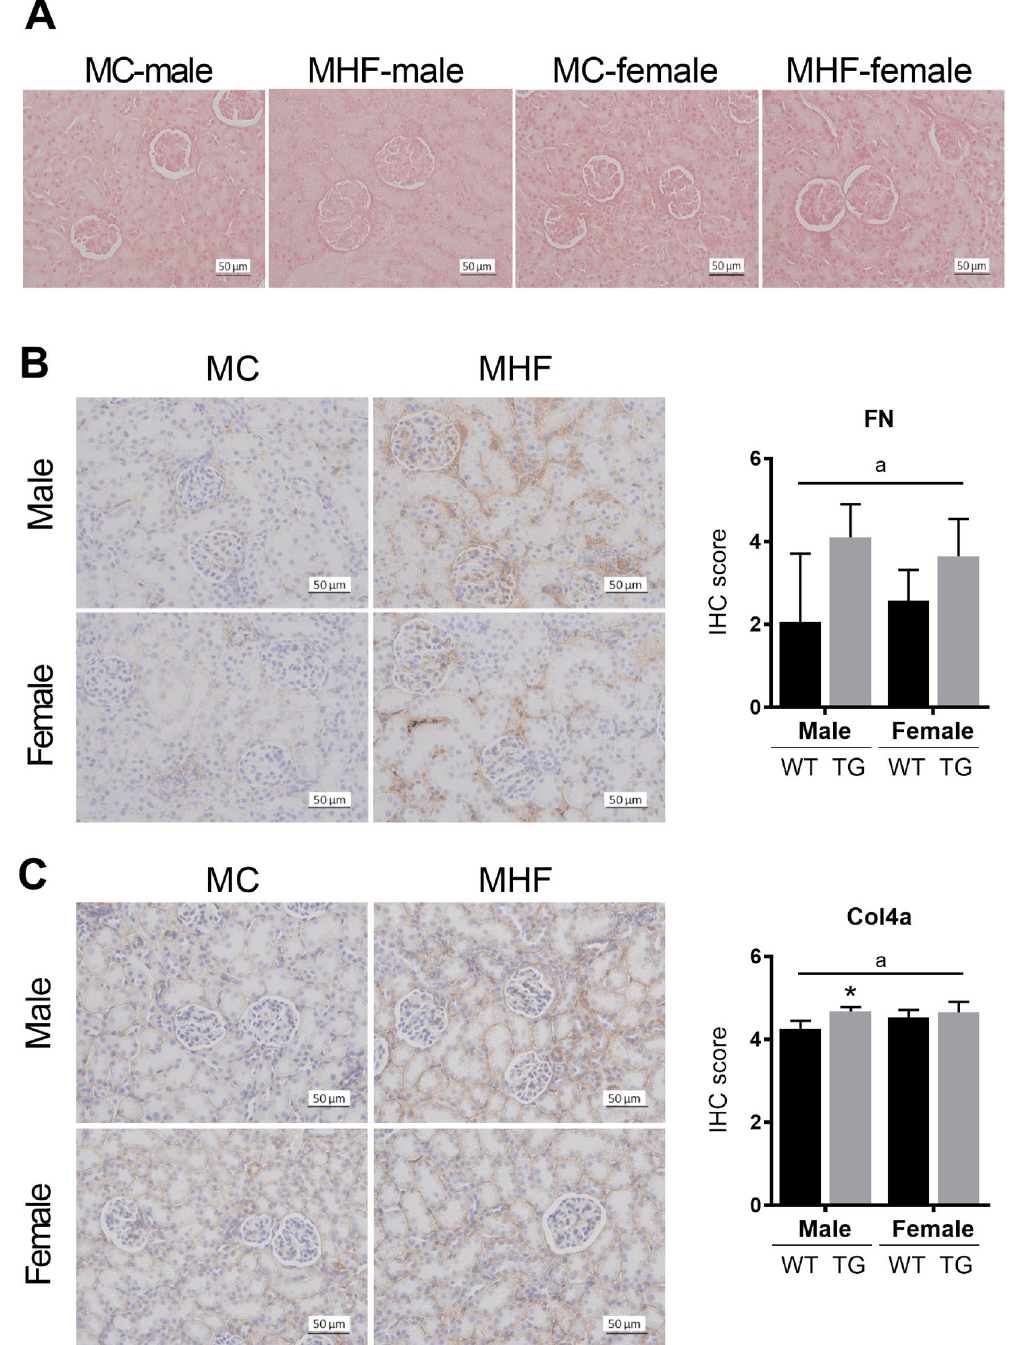
Figure 6. Renal histological staining in male and female offspring. ( A ) Picro Sirius Red staining of collagen type I and III. ( B ) Fibronectin immunohistochemistry. ( C ) Collagen type IV immunohistochemistry. MC (offspring of dams fed chow); MHF (offspring of dams fed high-fat diet). FN (Fibronectin); Col4 (Collagen type IV). Results are expressed as mean ± SD. Data were analysed by two-way ANOVA followed by Bonferroni post hoc test. a (P < 0.05, Maternal diet effect), * P < 0.05 (vs MC offspring). n =